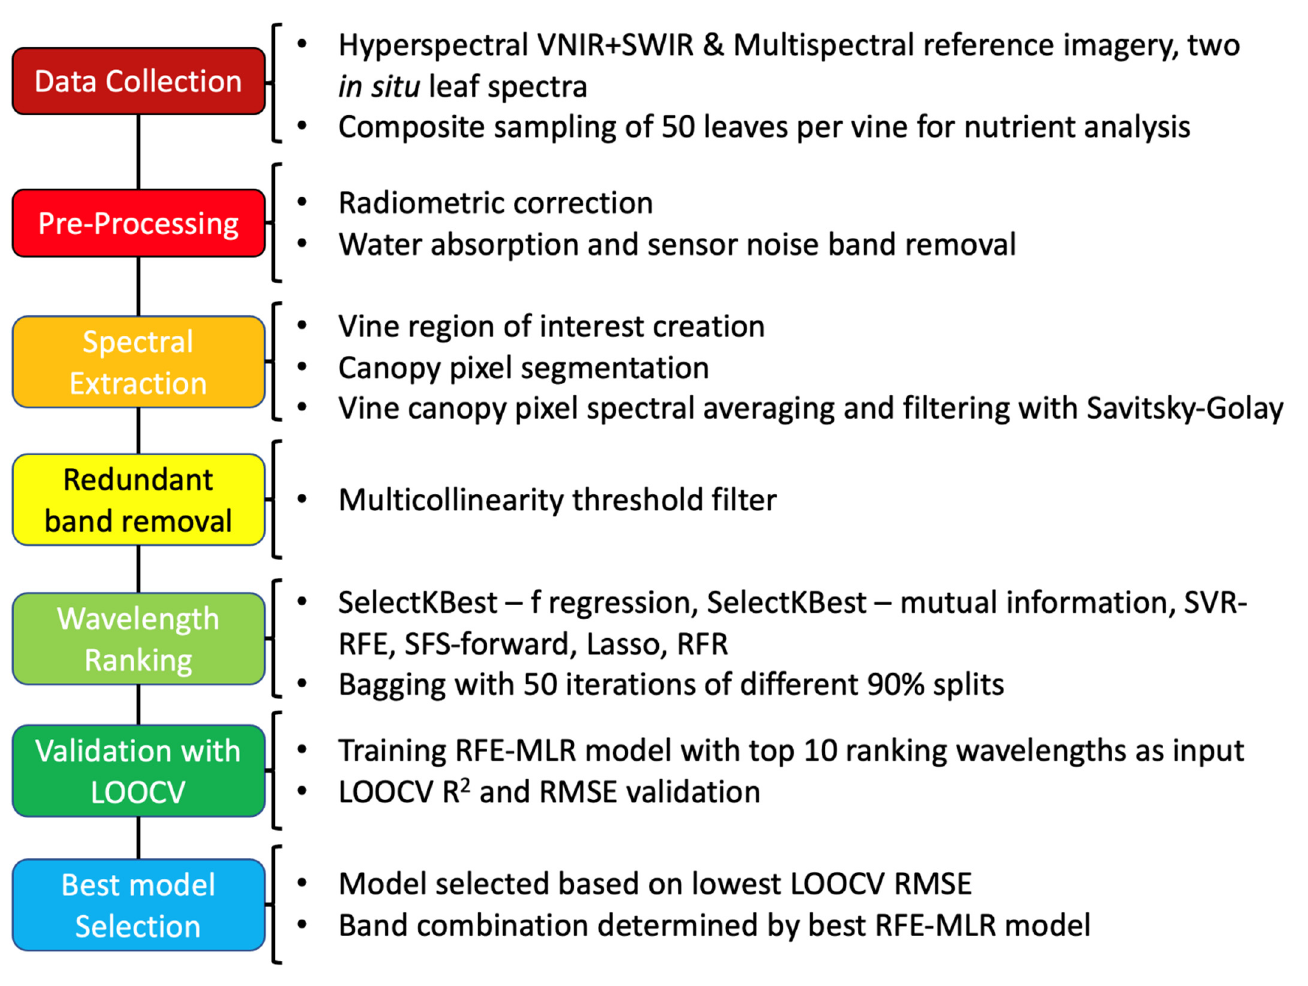
Figure A1. A flowchart of the steps used in the Methods section, from data collection to data analysis. Table A1 shows a compilation of the selected wavelengths for each nutrient model. The wavelengths in bold were selected using both methods. Table A1. List of the selected wavelengths for all the nutrient models.